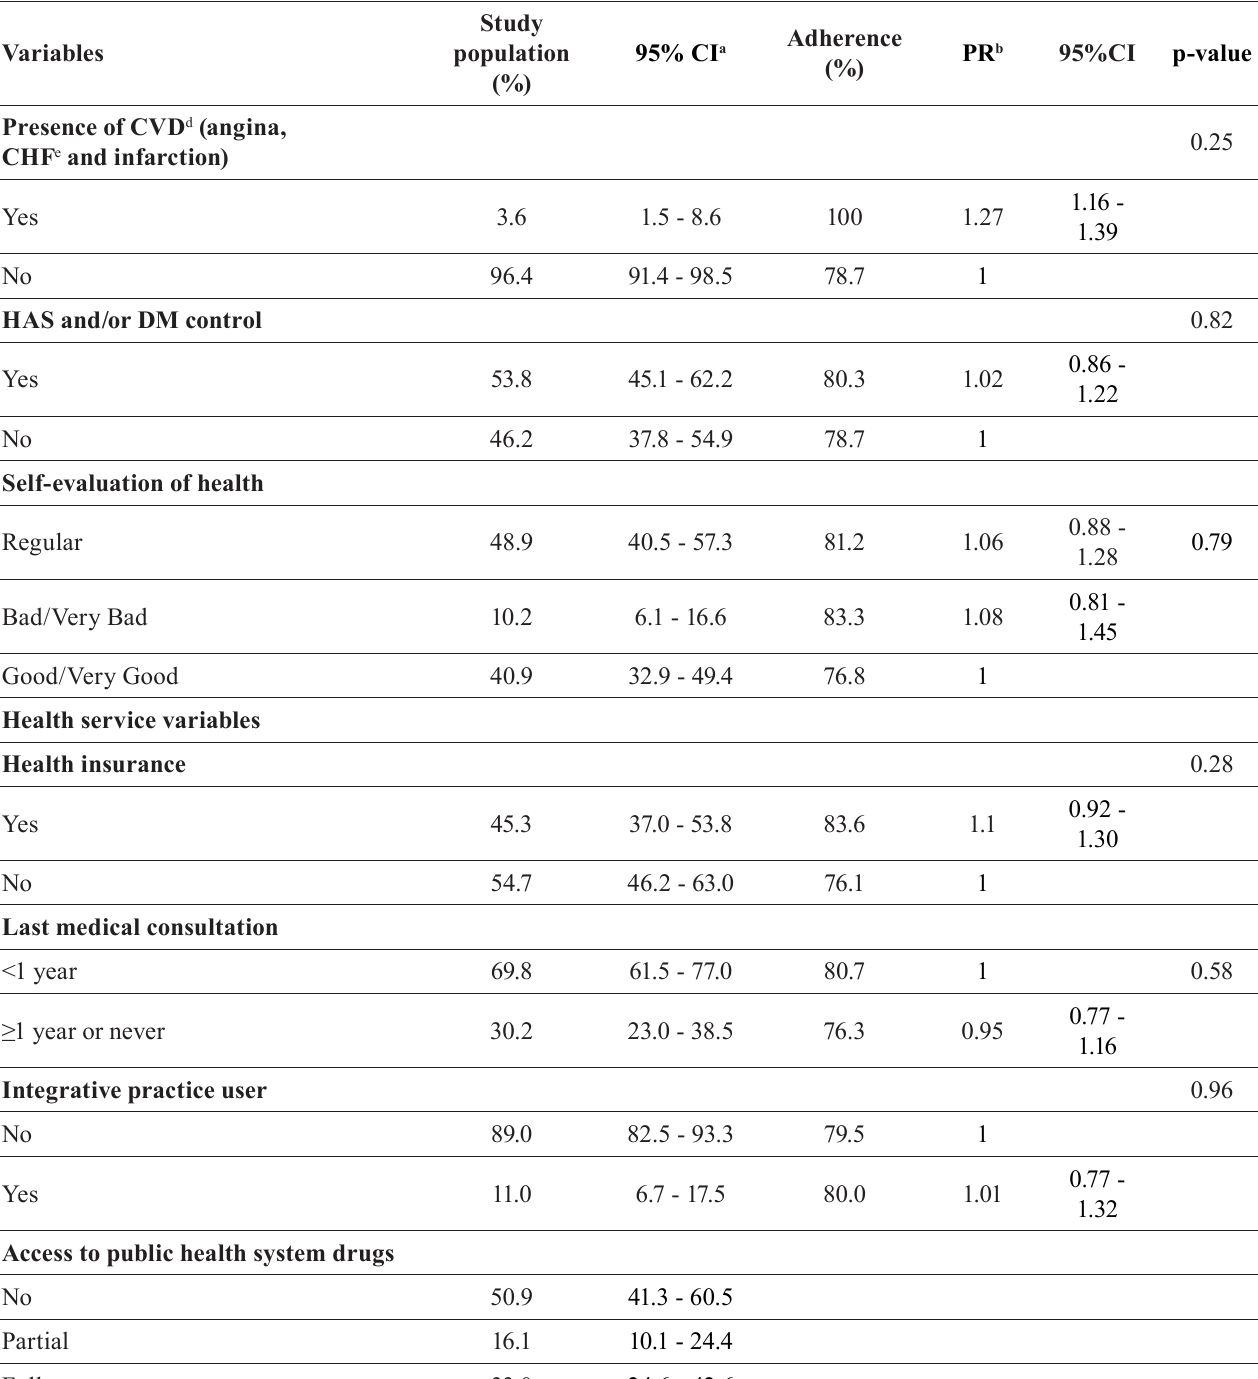
Study population